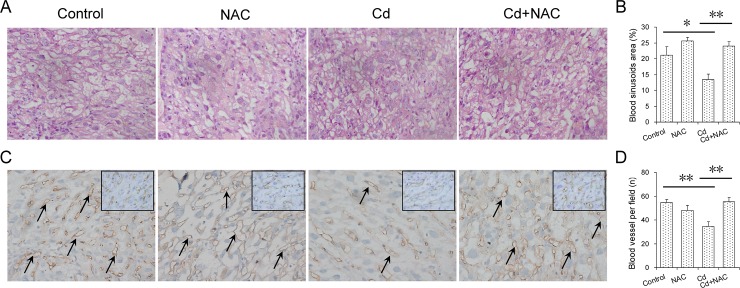
Effects of NAC on Cd-induced impairment of placental vascular space.All pregnant mice except controls were i.p. injected with CdCl2 (1.0 mg/kg) daily from GD13 to GD17. In NAC+Cd group, pregnant mice were i.p. injected with NAC (1.0 g/kg) daily from GD12 to GD17, one dose (300 mg/kg) at 8 h before CdCl2 injection, one (400 mg/kg) at 30 min before CdCl2 injection, another (300 mg/kg) at 8 h after CdCl2 injection. Placentas were collected on GD 18. (A) Placental cross sections were stained with H & E. Original magnification: 200×. (B) Vascular area in the labyrinthine layer was estimated from two nonconsecutive sections in each placenta using the public domain NIH Image J Program. The blood sinusoid area (%) was calculated as the ratio between the number of pixels covered by the area defined by the threshold and the overall number of pixels in the image. (C) Placental CD34 was analyzed using immunohistochemistry. Representative photomicrographs of histological specimens in the labyrinthine layer among different groups. Original magnification: 200×. Arrows indicate CD34-positive blood vessels. The images using black line were captured at magnification of 400×. (D) CD34-positive blood vessels were counted. (B and D) All data were expressed as means ± SEM. (N = 14~20). * P<0.05, **P<0.01.